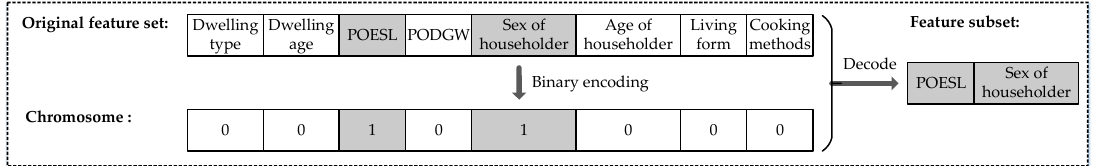
Figure 4. An example of chromosome encoding.